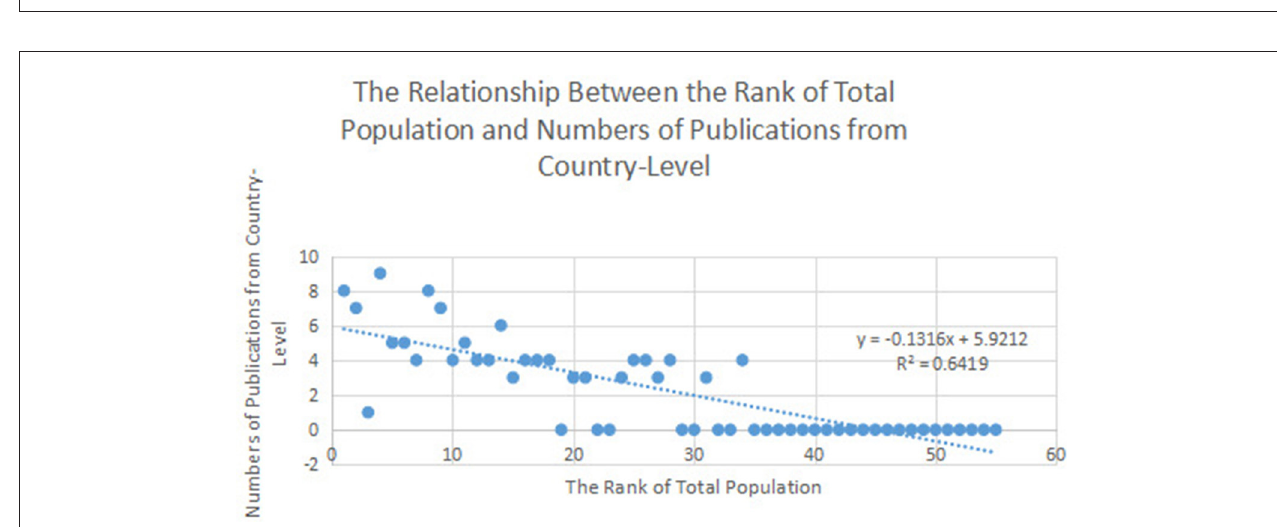
FIGURE 5 | The relationship between the rank of total population and numbers of publications from country-level.